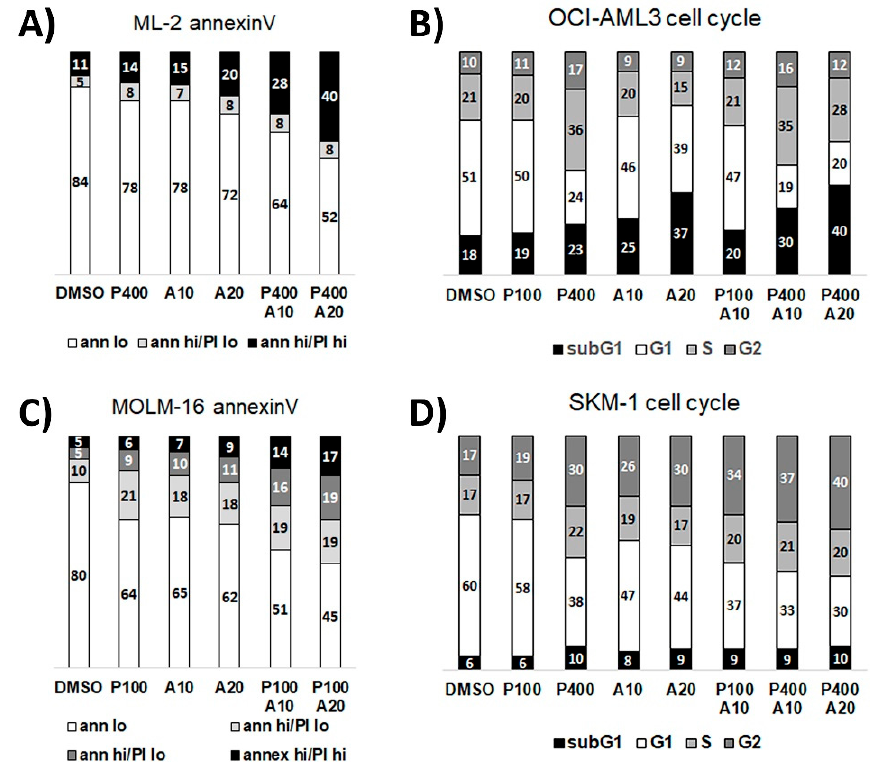
Figure 5. Dose-dependent induction of apoptosis and cell death in AML cells treated with PTC596 in combination with APR-246. Cytometric assays in AML cells treated for 20 h with PTC596 (P) and APR-246 ( A ) alone and in combination to measure induction of apoptosis using AnnexinV/PI staining in ML-2 ( A ) and MOLM-16 ( C ), and induction of cell death (subG1 fraction) using DAPI staining in OCI-AML3 ( B ) and SKM-1 ( D )